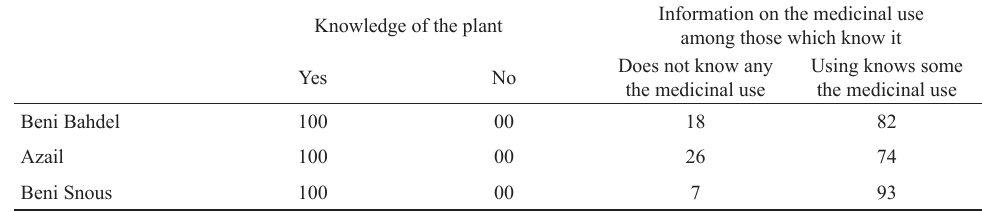
Table 2. Statistical results of the investigation into Chamaerops humilis in the area of Beni Snous.